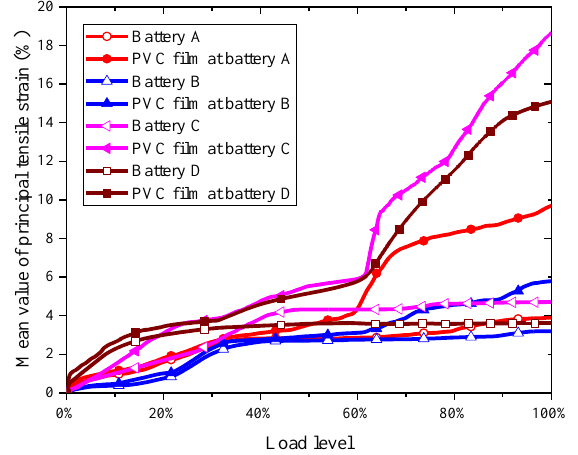
Figure 7. Relation between principal tensile strain and load level.